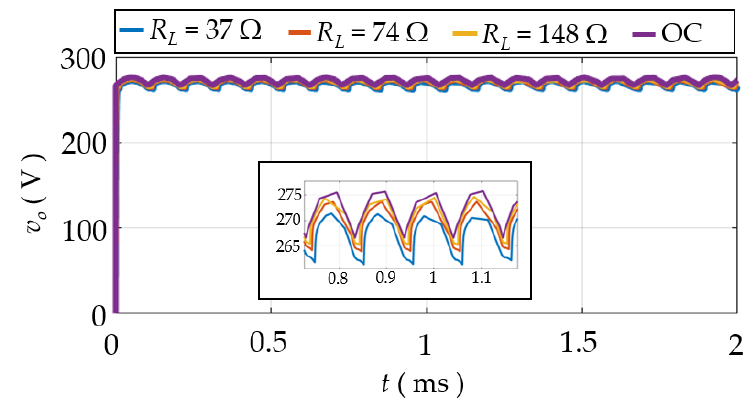
Figure 8. CTU output voltage waveforms.